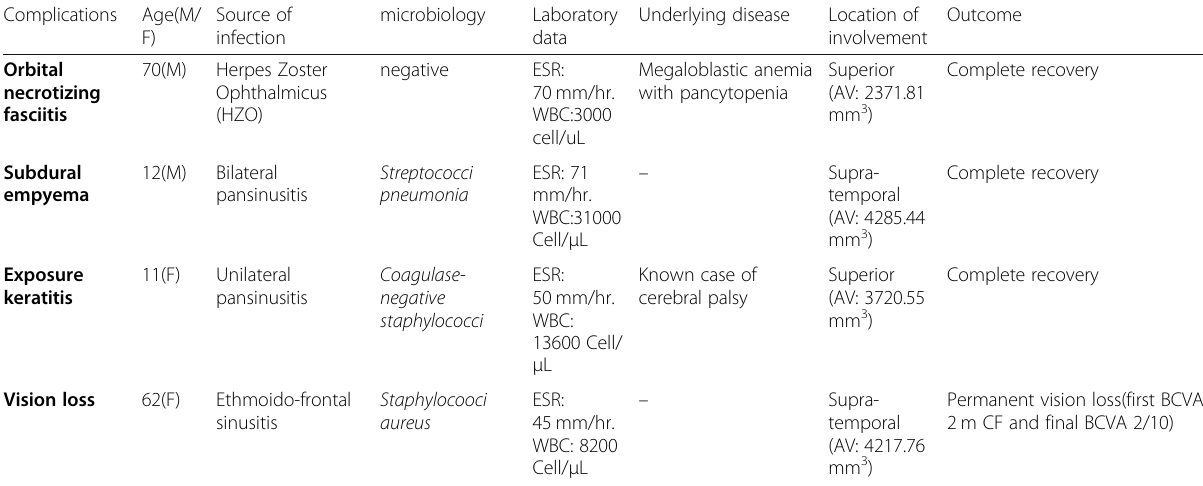
Table 5 Clinical Characteristics of four non-medial Orbital Cellulitis patients with complications Complications Age(M/ F)